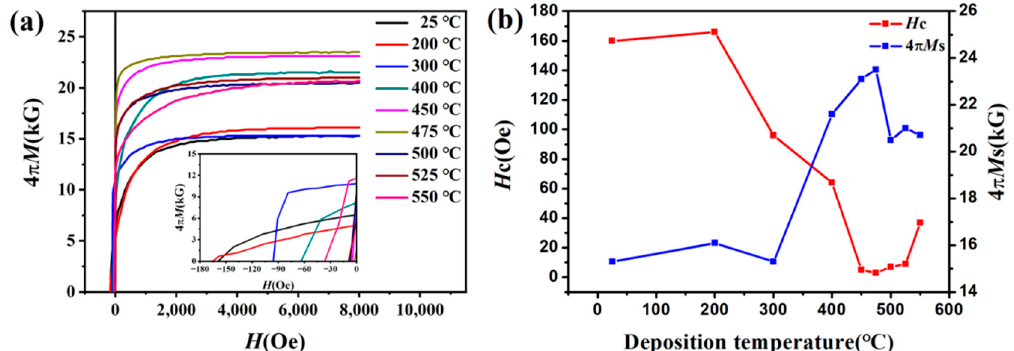
Figure 10. ( a ) Demagnetization curves of FeCo films with thickness of 800 nm deposited at different temperatures, and ( b ) dependence of the coercivity and saturation magnetization on deposition temperature.